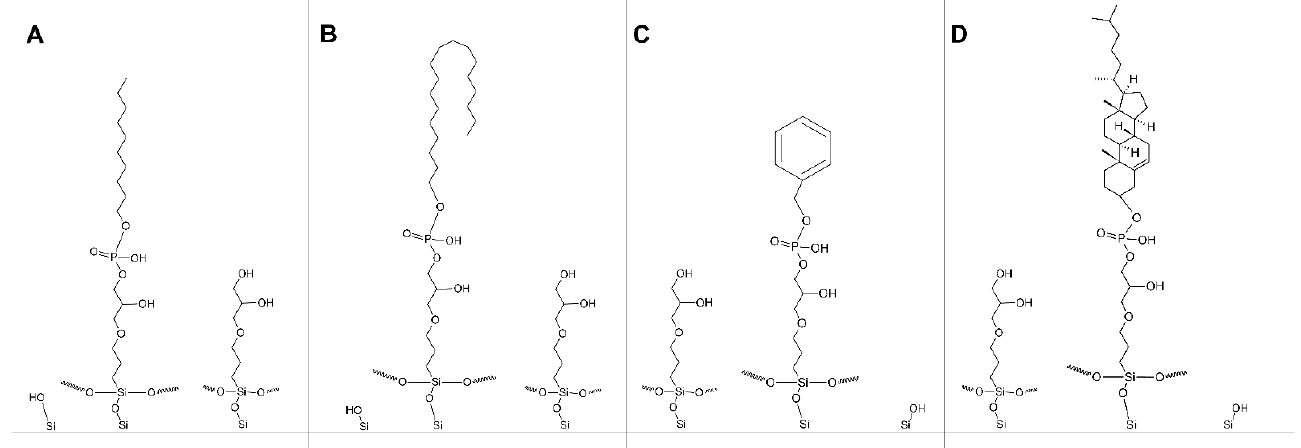
Figure 3. Schematic representation of stationary phase structures with embedded phosphodiester groups. ( A ) Diol- P -C10, ( B ) Diol- P -C18, ( C ) Diol- P -Benzyl, and ( D ) Diol- P -Chol. Each diagram also presents the structures of unreacted diol and residual silanols.